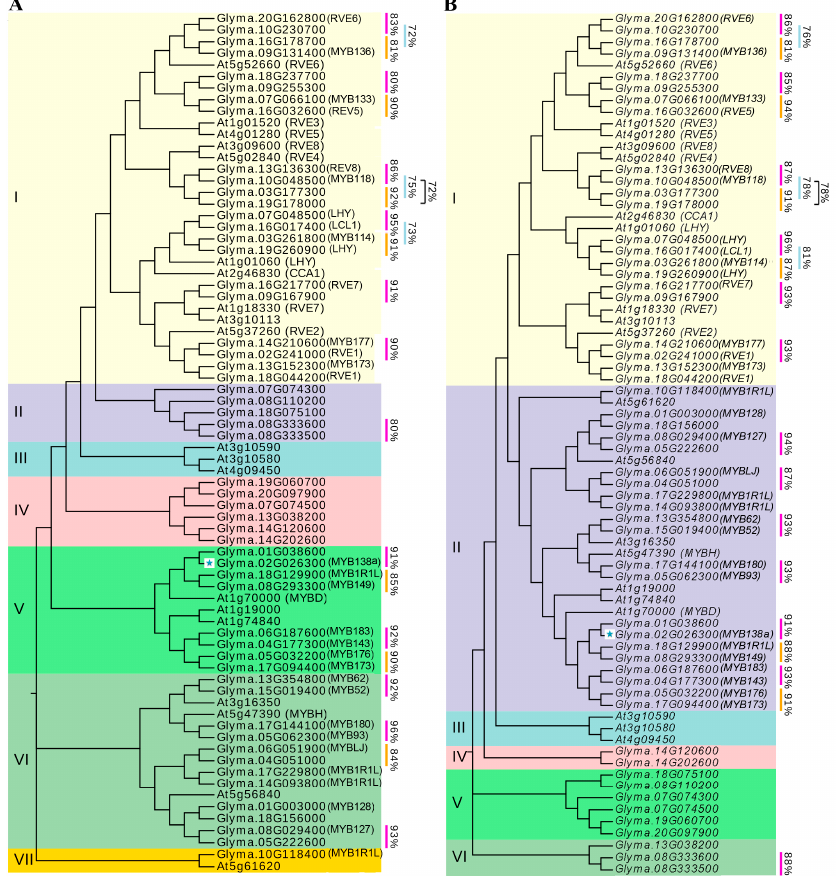
Figure 1. Phylogenetic analysis of CCA1-like subfamily between soybean and Arabidopsis. Phylogenetic trees were generated using: protein matrix ( A ); and CDS (Coding sequence) matrix ( B ), and groups are indicated by roman letters (I-VII/VI). The percent identity between duplicated gene pair is listed, and GmMYB138a (Glyma.02g026300) is marked with a star.